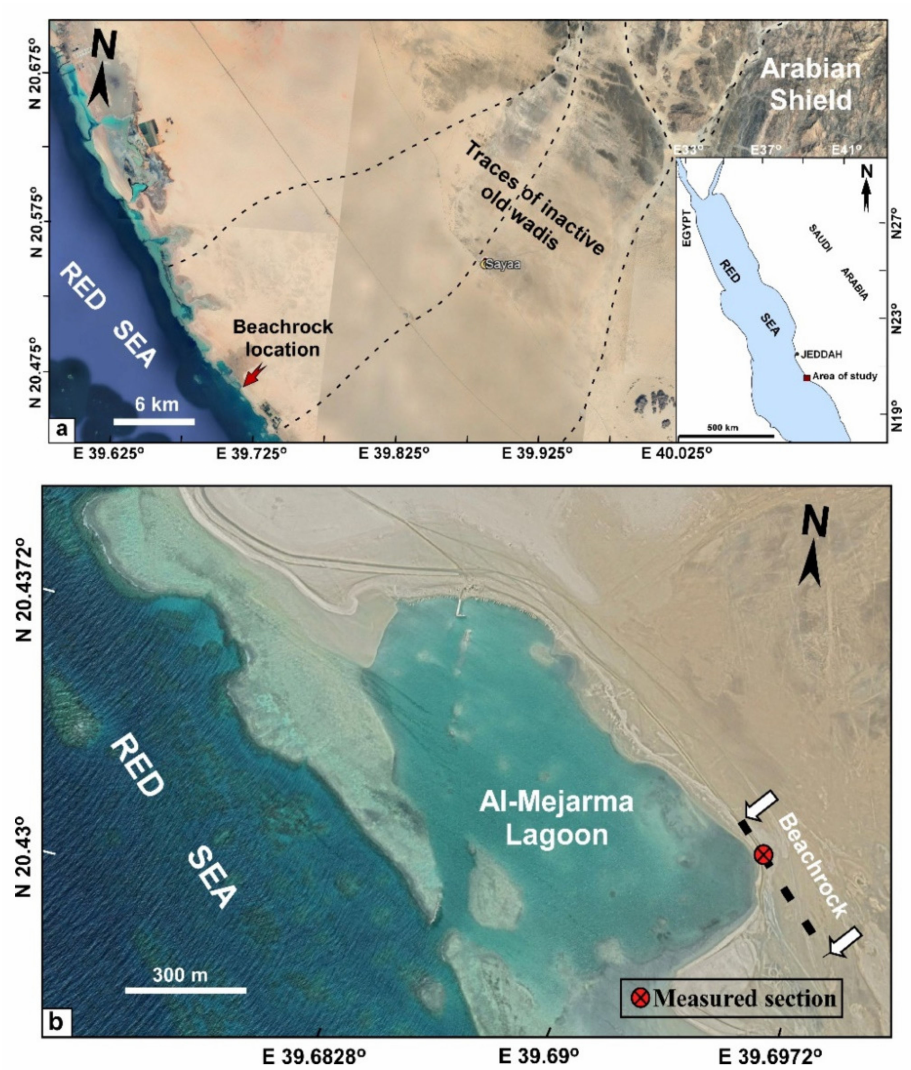
Figure 1. Landsat image showing the location of the area of study: ( a ) Location map of the study area; ( b ) Close up of Al-Mejarma Lagoon showing the extension of the beachrock and the location of the measured